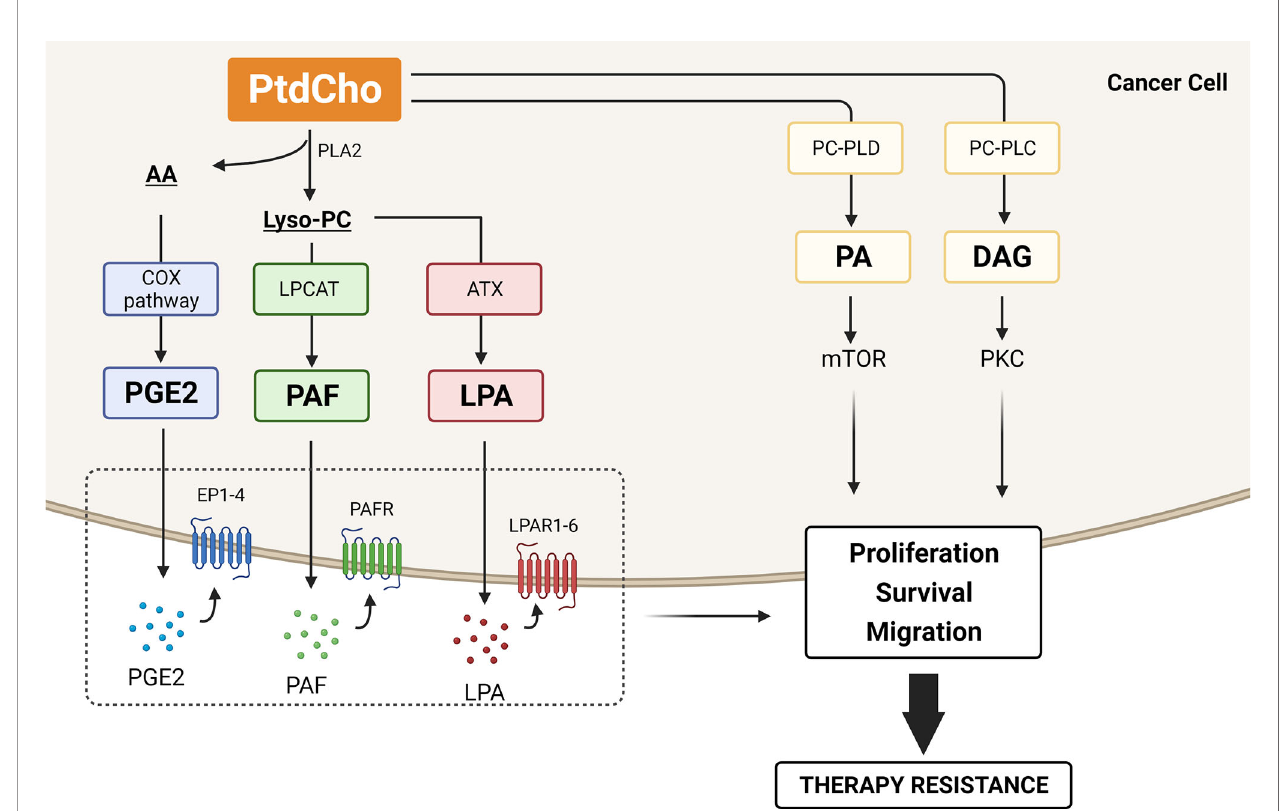
FIGURE 4 | Lipid mediators generated by phosphatidylcholine (PtdCho) turnover that contribute to therapy resistance. PtdCho is hydrolyzed by phospholipase A2 (PLA 2 ), resulting in the production of lysophosphatidylcholine (lyso-PC) and arachidonic acid (AA). The COX2 enzymes catalyze the conversion of AA to prostaglandin E2 (PGE2), and lyso-PC acetyltransferases (LPCATs) convert lyso-PC into platelet-activating factor (PAF). Alternatively, lyso-PC can be hydrolyzed by autotaxin (ATX) and generate lysophosphatidic acid (LPA). These three lipid mediators, PGE2, PAF, and LPA, are secreted and bind to their cognate receptors EP1-4, PAFR, and LPAR1-6, respectively, promoting cancer cell proliferation, survival, and migration. PtdCho is also hydrolyzed by phosphatidylcholine phospholipase C (PC-PLC) and D (PC-PLD), generating diacylglycerol (DAG) and phosphatidic acid (PA). DAG activates the protein kinase C (PKC) pathway, and PA is crucial for mTOR activity, promoting cancer cell proliferation and survival. All these catabolic products of PtdCho have been involved in therapy resistance. Created with